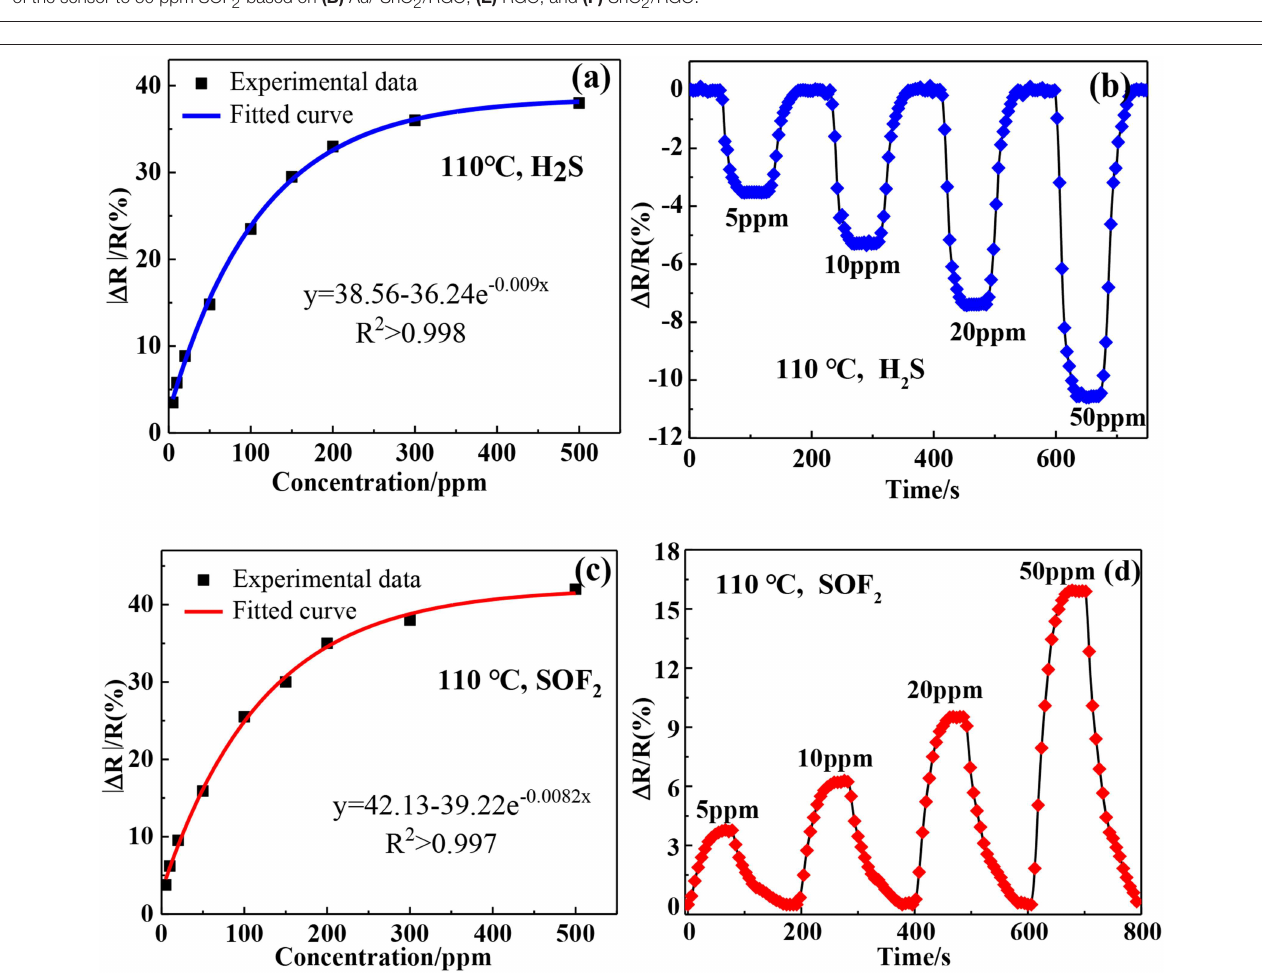
FIGURE 9 | Experimental responses and fitting models toward (a) H 2 S and (c) SOF 2 based on Au-SnO 2 -RGO sensor at 110 ◦ C. The response-recovery curves of Au-SnO 2 -RGO sensor to 5–50 ppm of (b) H 2 S and (d) SOF 2 at 110 ◦